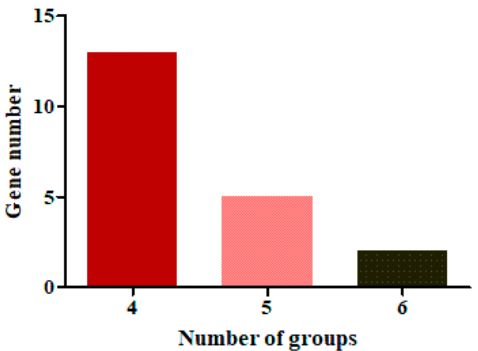
Figure 4. The statistics of common DEGs among groups. The abscissa indicates the number of groups with the same DEGs. The ordinate shows the number of common DEGs in the various numbers of groups. Table 4. Functional annotation of the common DEGs in high-yield vs. low-yield silkworms.